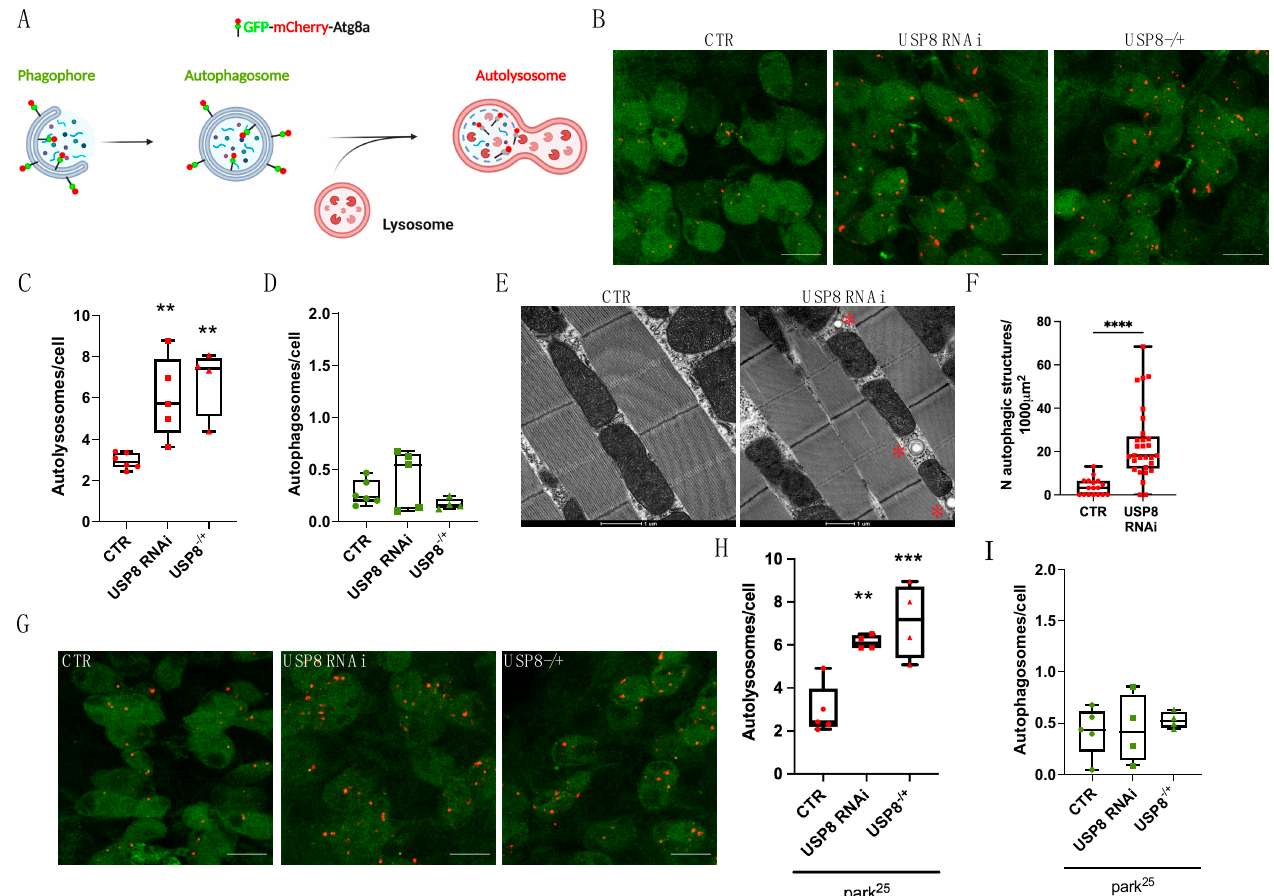
Figure 1. ( A ) Graphical representation of the GFP–mCherry–Atg8a construct. A tandem mCherry–GFP tag is fused to Atg8a. In conditions of neutral pH such as the cytosol, autophagosomes display both mCherry and GFP fluorescence. The GFP signal is quenched upon autophagosomes fusion to lysosomes. In the acidic environment of the lysosomes, the number of mCherry-only foci (red dots) allows quantification of on-going autophagy. Created with BioRender.com. ( B ) Confocal microscopy analysis of larval VNC neurons expressing GFP–mCherry–Atg8a. mCherry-only puncta represent au- tolysosomes under basal condition (CTR) or upon USP8 down-regulation (USP8 RNAi and USP8 − /+ ). ( C ) Quantification of autolysosomes (red-only dots) per cell in the three different conditions. Statisti- cal significance determined by one-way ANOVA with Dunnett’s post-test correction; ** = p < 0.01. ( D ) Quantification of autophagosomes per cell in the three different conditions. Statistical significance determined by Kruskal–Wallis test with Dunn’s multiple comparison. ( E ) Representative electron microscopy images of flight muscle mitochondria of the indicated genotypes; * indicate autophago- some stractures. ( F ) Quantification of ( E ). Box plot represents quantification of autophagic vesicles formation in the flight muscle of the indicated genotypes. Statistical significance determined by Student’s t test. **** = p < 0.0001. ( G ) Confocal microscopy analysis of larval VNC neurons expressing GFP–mCherry–Atg8a in park 25 flies. ( H ) Quantification of autolysosomes (red-only dots) per cell in the three different conditions. Statistical significance determined by one-way ANOVA with Dunnett’s post-test correction; ** = p < 0.01; *** = p < 0.001. ( I ) Quantification of autophagosomes per cell in the three different conditions. Statistical significance determined by Kruskal–Wallis test with Dunn’s multiple comparison. Unless differently indicated, scale bars = 10 µ m. Genotypes analysed (confo- cal microscopy): UAS GFP-mCherry-Atg8a/+; nSybGAL4/+ (CTR), UAS GFP-mCherry-Atg8a/+; nSybGAL4/UAS USP8 RNAi (USP8 RNAi) and UAS GFP-mCherry-Atg8a/+; nSybGAL4/USP8 KO (USP8 − /+ ). Genotypes analysed (TEM): Act5cGAL4/+ (CTR), Act5cGAL4/+; UAS USP8 RNAi/+ (USP8